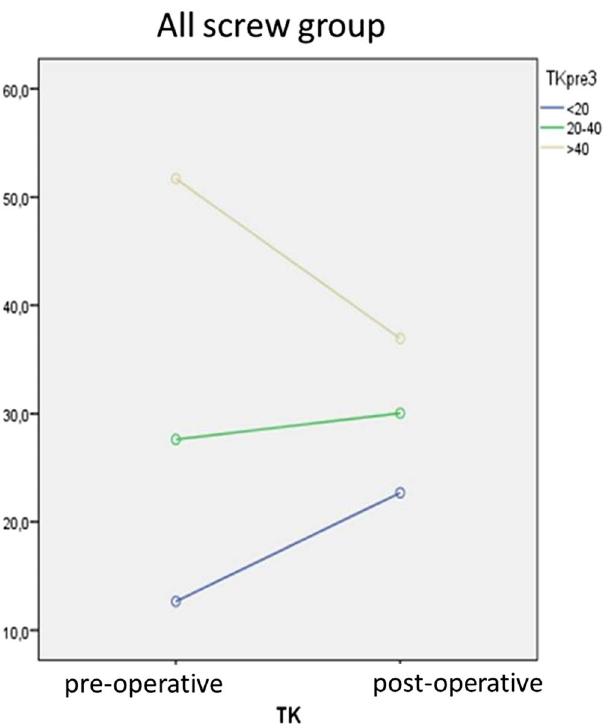
Figure 3. Thoracic Kyphosis correction in Group 1 (All Screw), statistical analysis performed using IBM SPSS Statistics